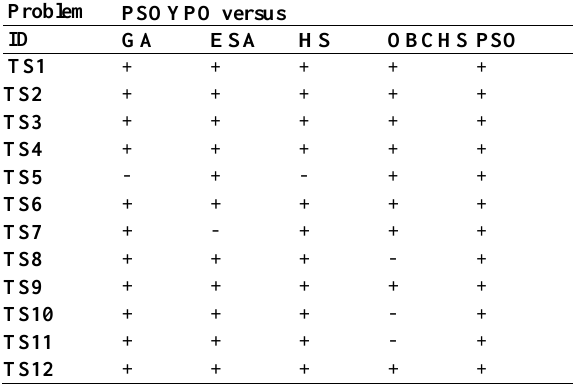
Table 9. Results of the statistical